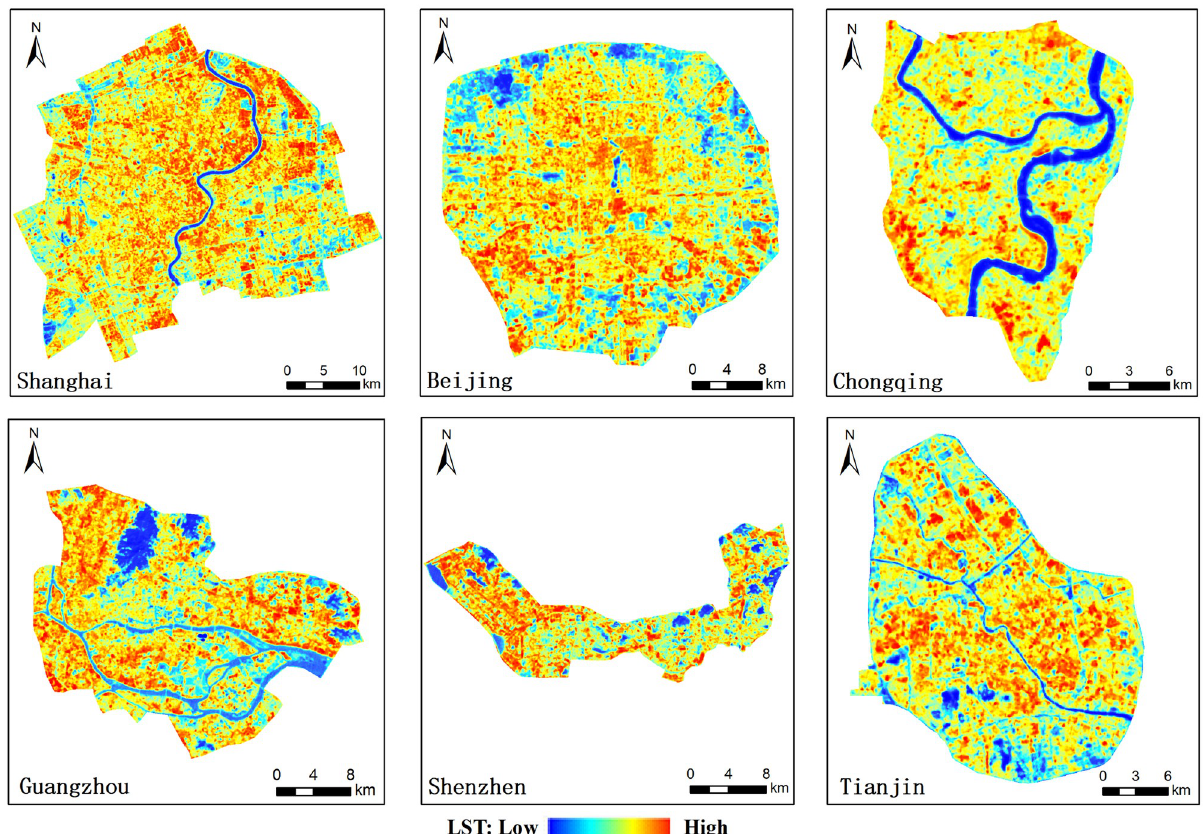
Fig 5. Spatial distribution of LST of six megacities (USGS/NASA Landsat 8).